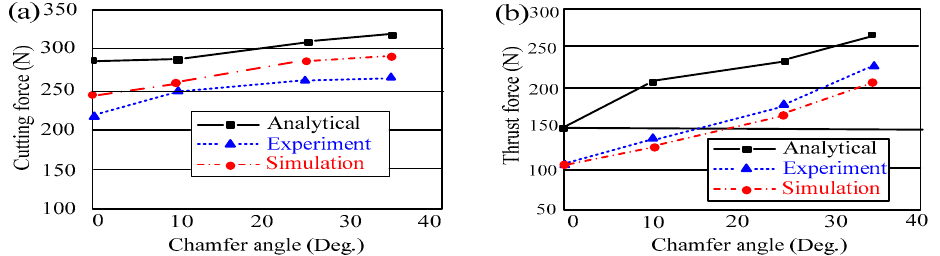
Figure 6. Comparisons of ( a ) cutting force and ( b ) thrust force between analytical, experimental, and simulation results with different chamfer angles [25].